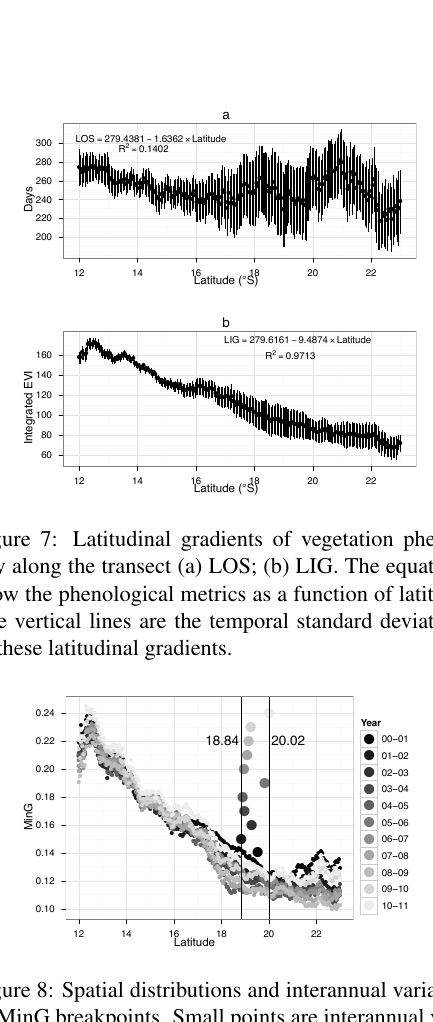
Figure 8: Spatial distributions and interannual variation of MinG breakpoints. Small points are interannual vari- ations of annual minimum EVI along the latitude, large points are interannual variations of breakpoints. The north and south boundaries of these breakpoints are in- dicated by two vertical lines. The numbers give the ac- tual latitudes of north and south